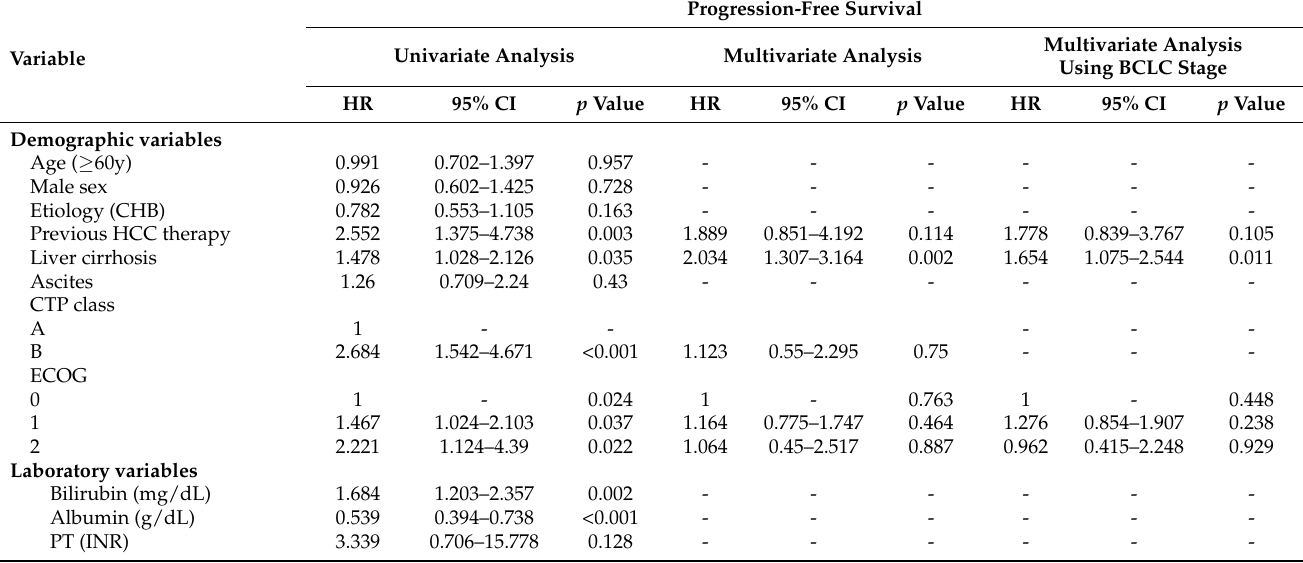
Table 4. Factors contributing to progression-free